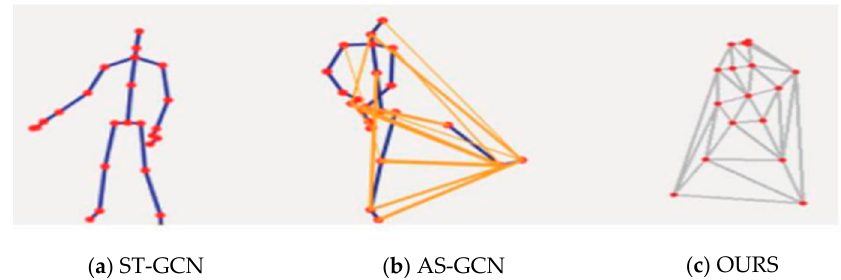
Figure 10. Topology of the ST-GCN, AS-GCN, and our algorithm.